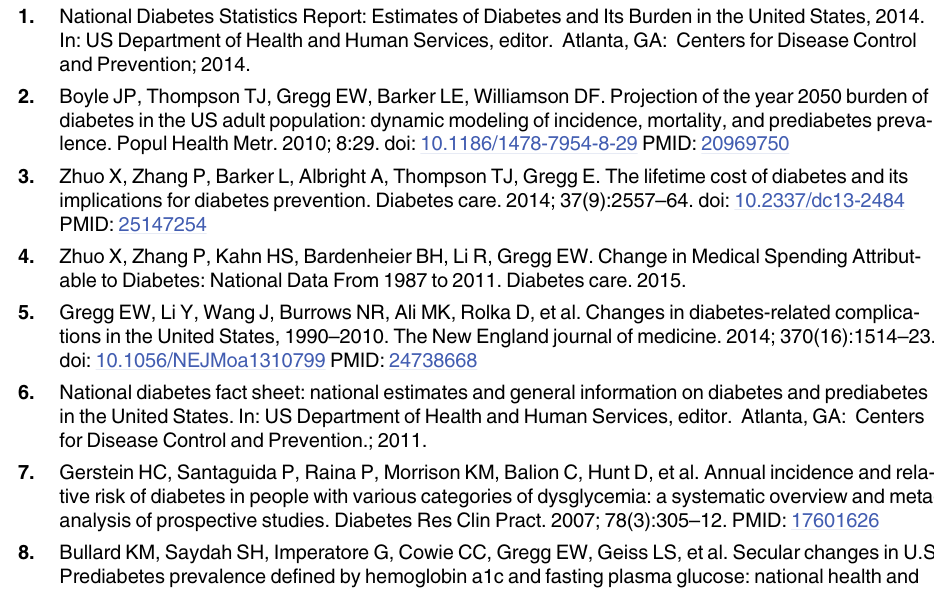
S1 Table. List of search terms. S2 Table. Baseline participant and intervention characteristics by study. S3 Table. Scoring system adapted from the Juni scoring